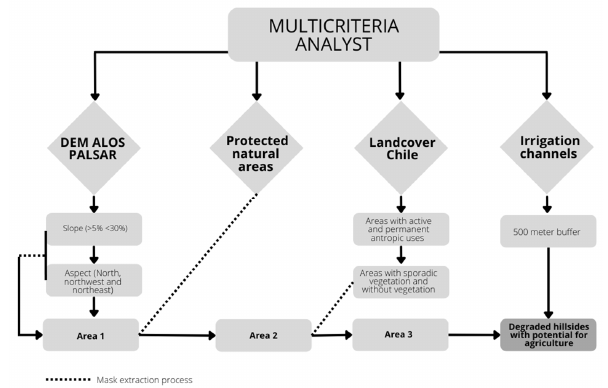
Figure 3. Flowchart of the research procedure. Table 1. Criteria and exclusive areas for the identification of degraded hillsides and their sources. Types of Hillsides in the Study Area Criteria for Identification Sources for Classification Plain areas